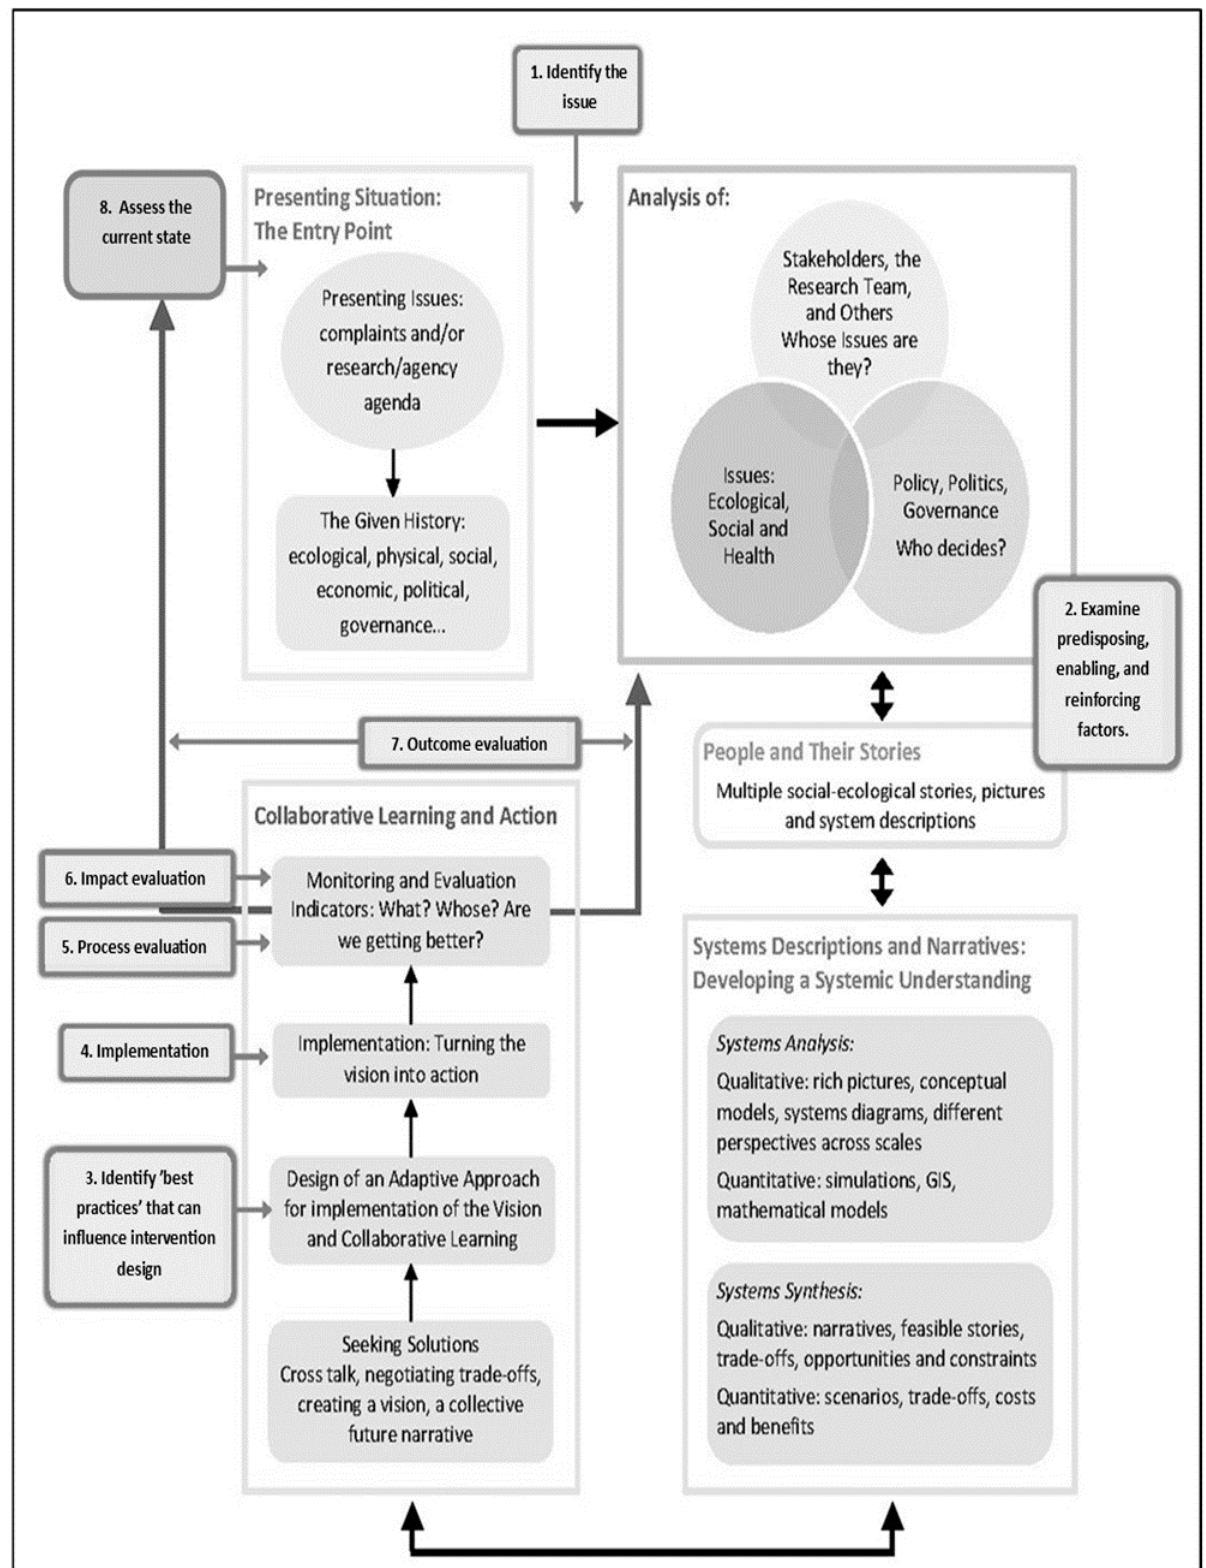
Figure 1. An adaptive framework for evidence-informed parks management and policy.